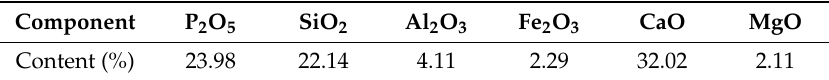
Table 1. Chemical composition of raw